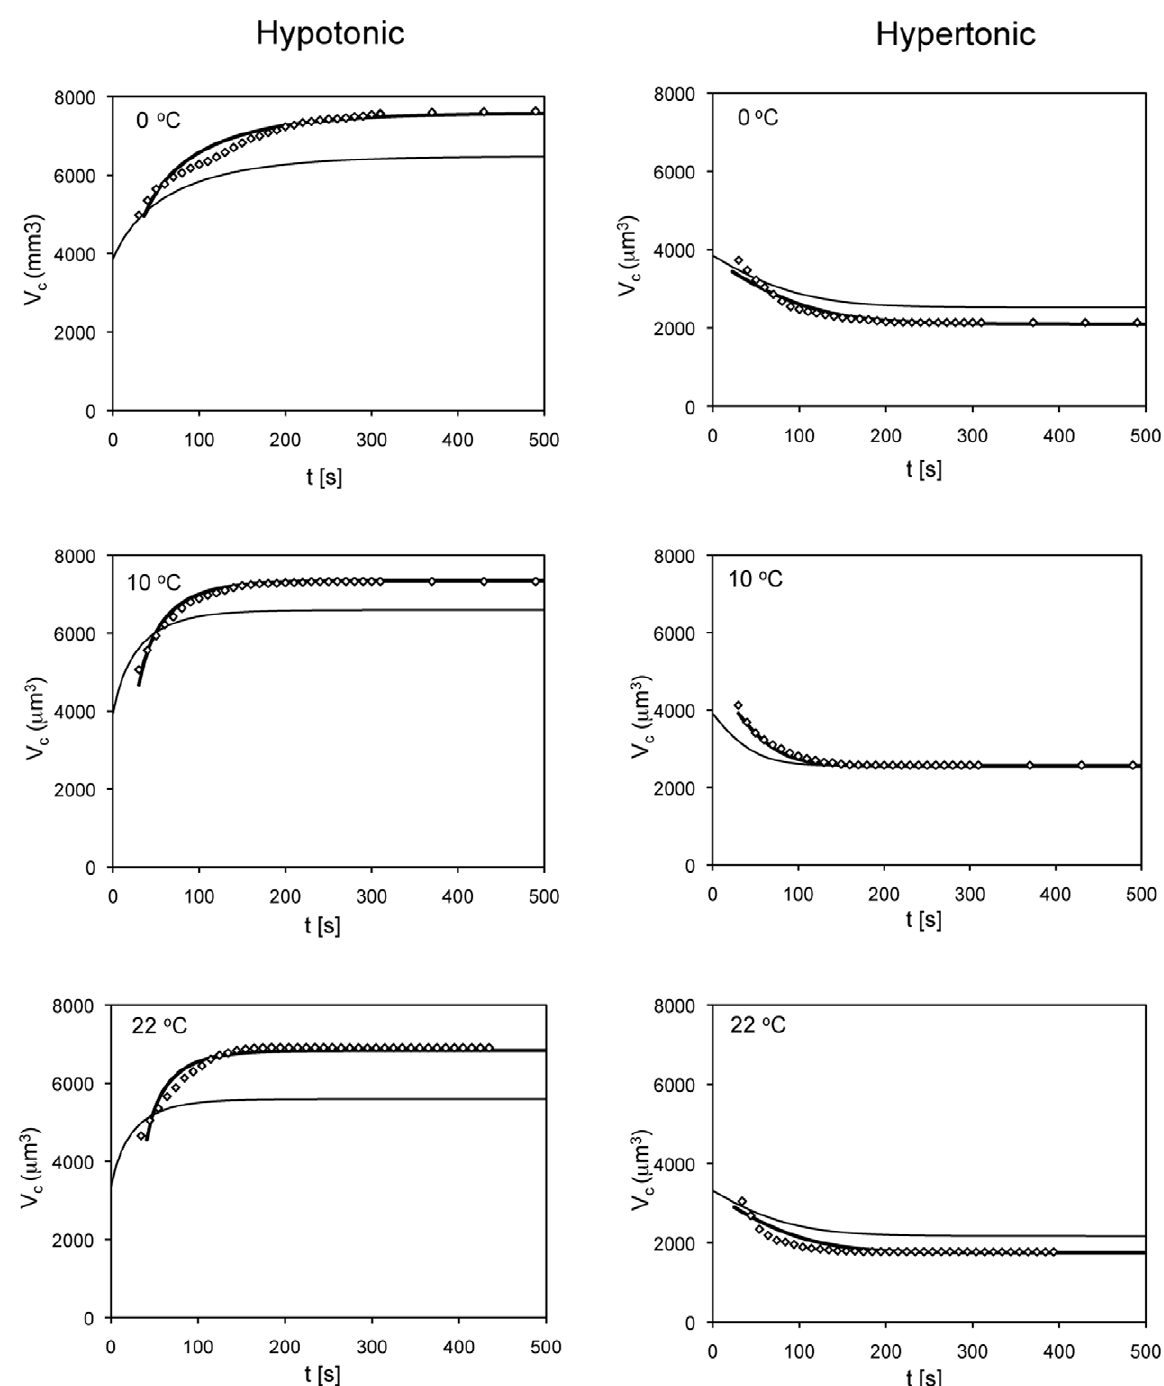
Figure 7. Comparison of the experimental data with computer simulations. Plots of the volumes of COS-7 cells as function of time under hypotonic conditions (left column) and under hypertonic conditions (right column). The diamonds are the experimental values. The light solid line is the simulated curve obtained by calculating the cell volumes as a function of time using the classical differential equation [Eq 3]. The heavy solid line was obtained by sliding the light line in the X and Y directions to obtain the best fit by eye to the experimental points.